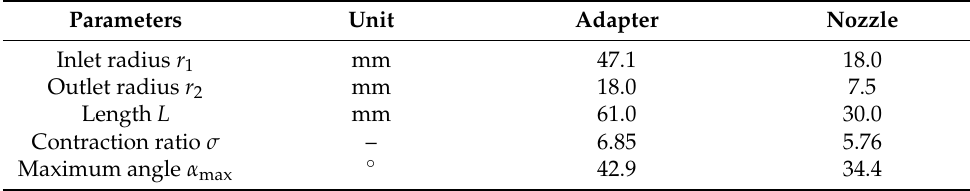
Table 1. Parameters describing the geometry of the contraction.